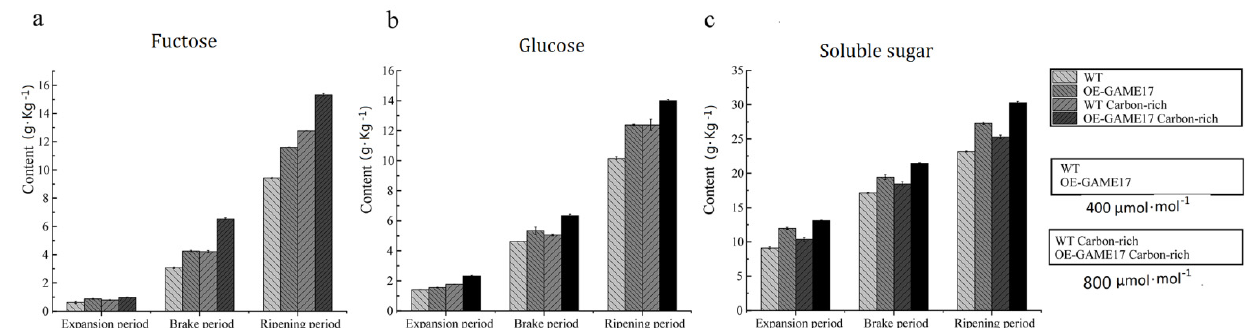
Figure 8. Comparison of the content of glucose, fructose, and soluble sugar in WT and transgenic tomato fruits. The fructose content in tomato fruits at three developmental stages of transgenic tomato and WT plants ( a ); the glucose content in tomato fruits at three developmental stages of transgenic tomato and WT plants ( b ); and the soluble sugar content in tomato fruits at three developmental stages of transgenic tomato and WT plants ( c ). Values represent the means ± SD ( n = 3) of three plants per line.